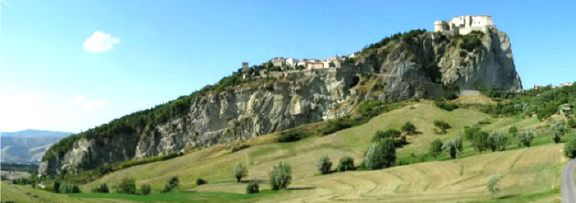
Figure 3. The village of San Leo on the top of the impregnable rock slab (view from the